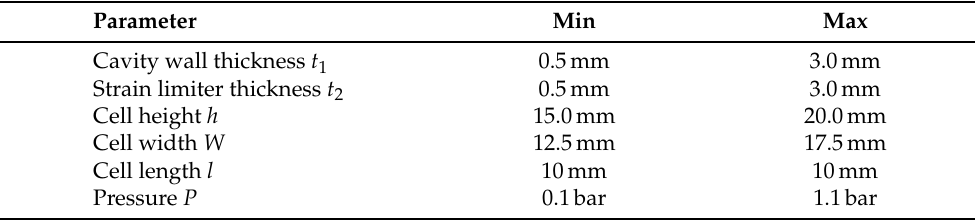
Table 2. Parameter ranges used in the DOE for a reduced-order model of a single bending actuator unit. Nominal values were taken from Ellis et al. [24] as t 1 = 1mm, t 2 = 2mm, h = 17.5mm, W = 15mm, and l =